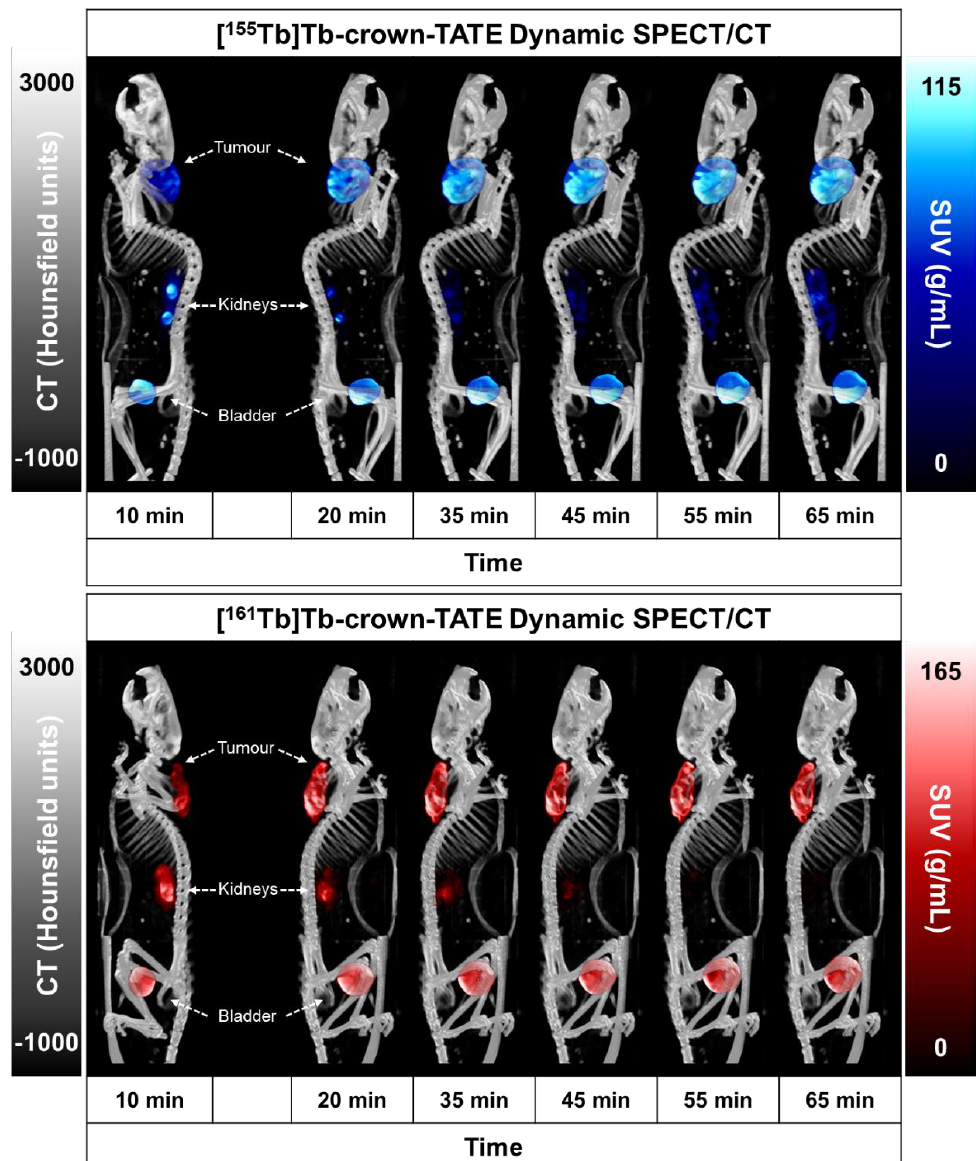
Figure 3. Maximum intensity projections (MIPs) from quantitative dynamic SPECT/CT scans recorded at 0–1 h post - administration of ( A ) [ 155 Tb]Tb - crown - TATE (13.8 MBq, 0.71 nmol) and ( B ) [ 161 Tb]Tb - crown - TATE (7.95 MBq, 0.70 nmol) in male NRG mice bearing AR42J tumour xenografts (left - shoulder).